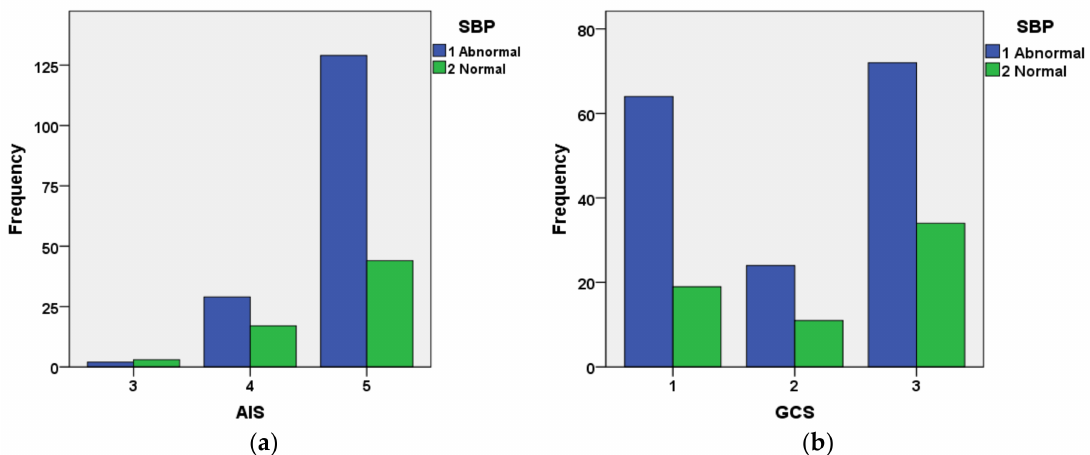
Figure 10. Relationship between ( a ) AIS and systolic blood pressure; ( b ) GCS and systolic blood pressure for cases that were included in the validation set and had not survived. Blue = abnormal category, Green = normal category.